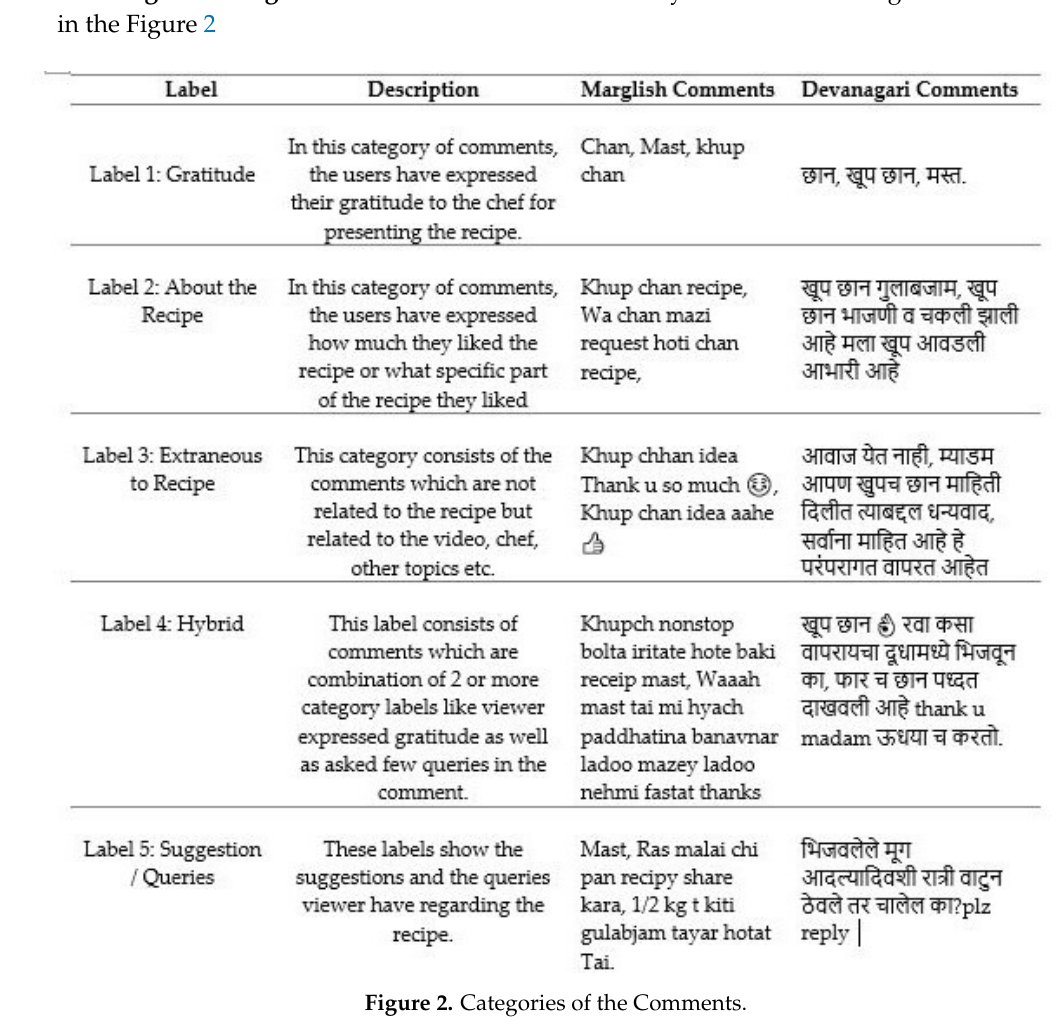
Figure 2. Categories of the